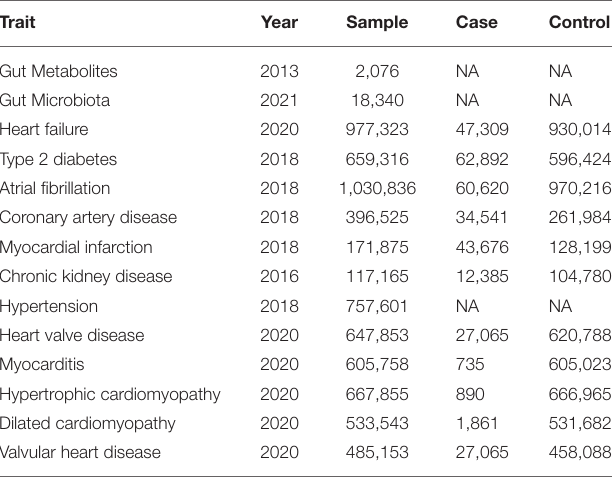
TABLE 1 | Gut microbiota and metabolites and heart failure and heart failure risk factors summary data sources.